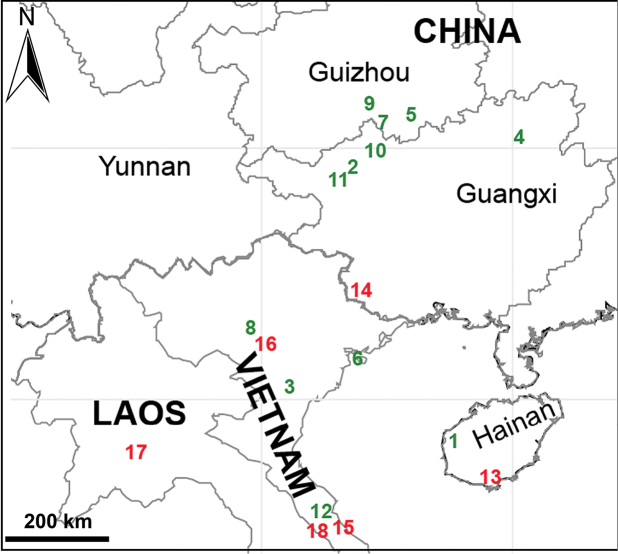
Distribution records of Pinelema spp., the xiezi-group (green) and species not attached to a species group (red): 1P.
breviseta comb. nov. 2P.
conglobare comb. nov. 3P.
cucphongensis comb. nov. 4P.
cucurbitina comb. nov. 5P.
dongbei comb. nov. 6P.
exiloculata comb. nov. 7P.
grandidens comb. nov. 8P.
laensis9P.
oculata comb. nov. 10P.
pedati comb. nov. 11P.
spinafemora comb. nov. 12P.
xiezi13P.
dengi comb. nov. 14P.
mikrosphaira comb. nov. 15P.
nuocnutensis16P.
spirulata17P.
tham sp. nov. 18P.
zhenzhuang.